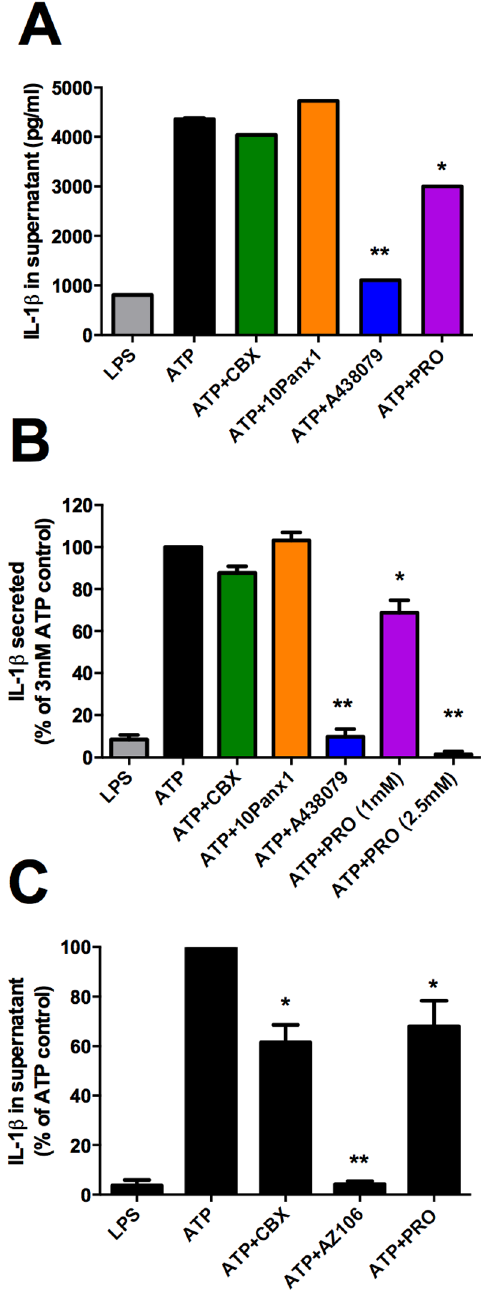
Figure 6. Probenecid but not pannexin-1 blockers reduce P2X7-induced IL-1 b secretion from human monocytes and J774 macrophages. Magnetically isolated CD14 + human monocytes were primed with LPS (100 ng/ml) for 4 hours and stimulated with 3 mM ATP for 15 minutes. After stimulation supernatants were removed and tested for IL-1 b . (A) representative data from one donor, (B) shows pooled data from 6 donors expressed as % of ATP control. Carbenoxolone (CBX) was used at 50 m M, probenecid (PRO) at 1 mM and 2.5 mM, 10 Panx1 at 100 m M, and A-438079 at 10 m M. (C) The J774 mouse macrophage cell line was primed with LPS (1 m g/ml) and stimulated with ATP (5 mM) for 20 minutes in physiological saline. P2X7 selectiveantagonist AZ10606120 (AZ106) was used at 10 m M. Mean data from three independent experiments is shown. ATP-induced IL-1 b released into supernatant was measured by specific ELISAs for human and mouse IL-1 b respectively. Error bars represent S.E.M and * represents P , 0.05. doi:10.1371/journal.pone.0093058.g006 PLOS ONE |